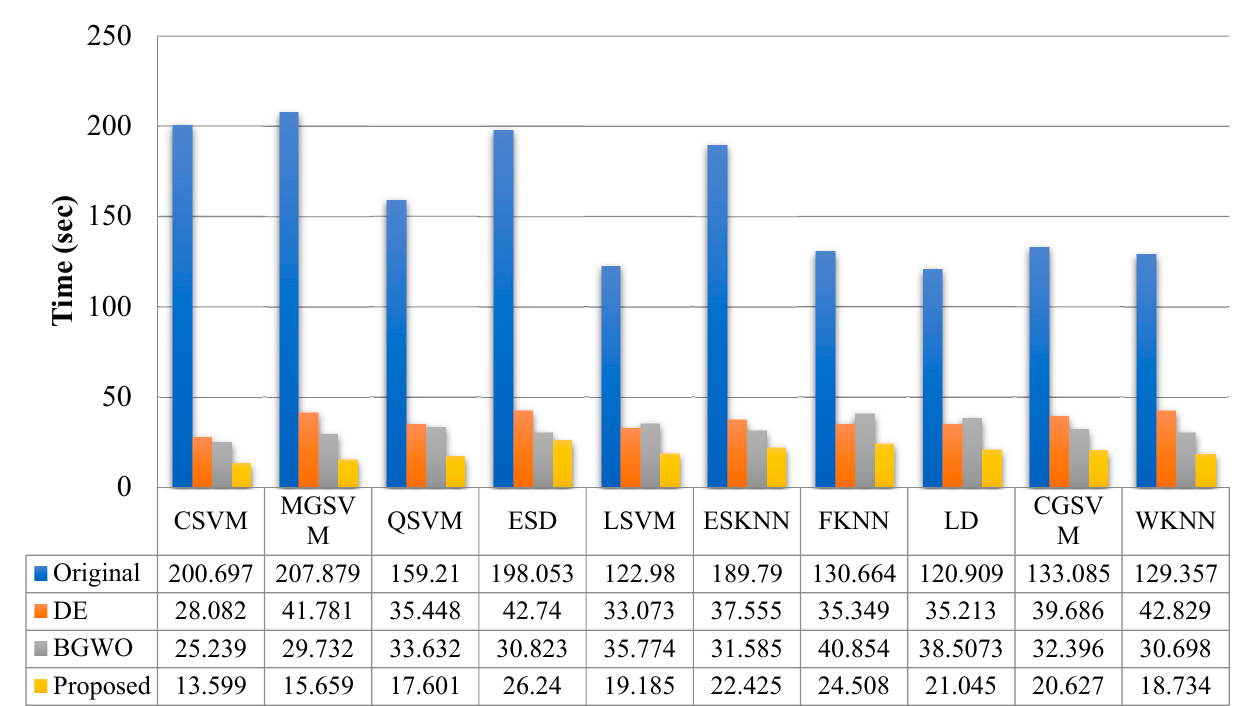
Figure 13. Computational time-based comparison of each step using the proposed framework.